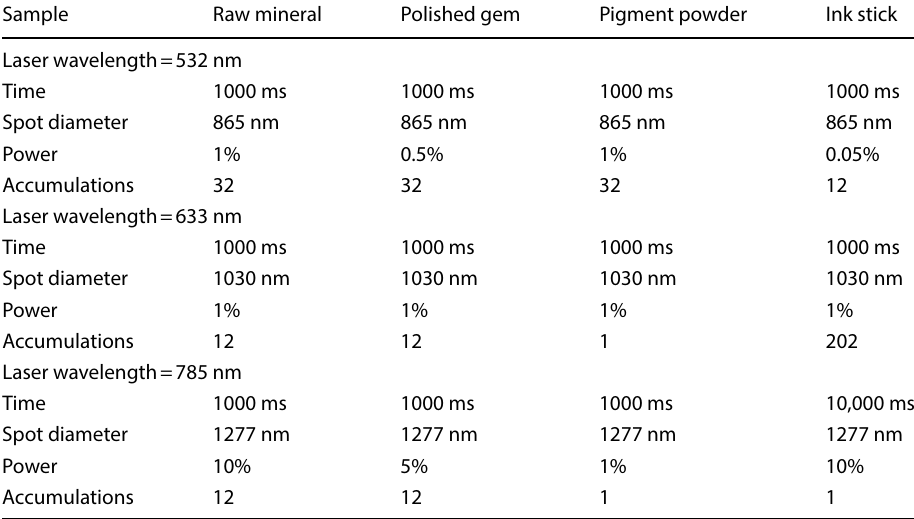
Table 1 Instrument parameters Sample Raw mineral Polished for different samples